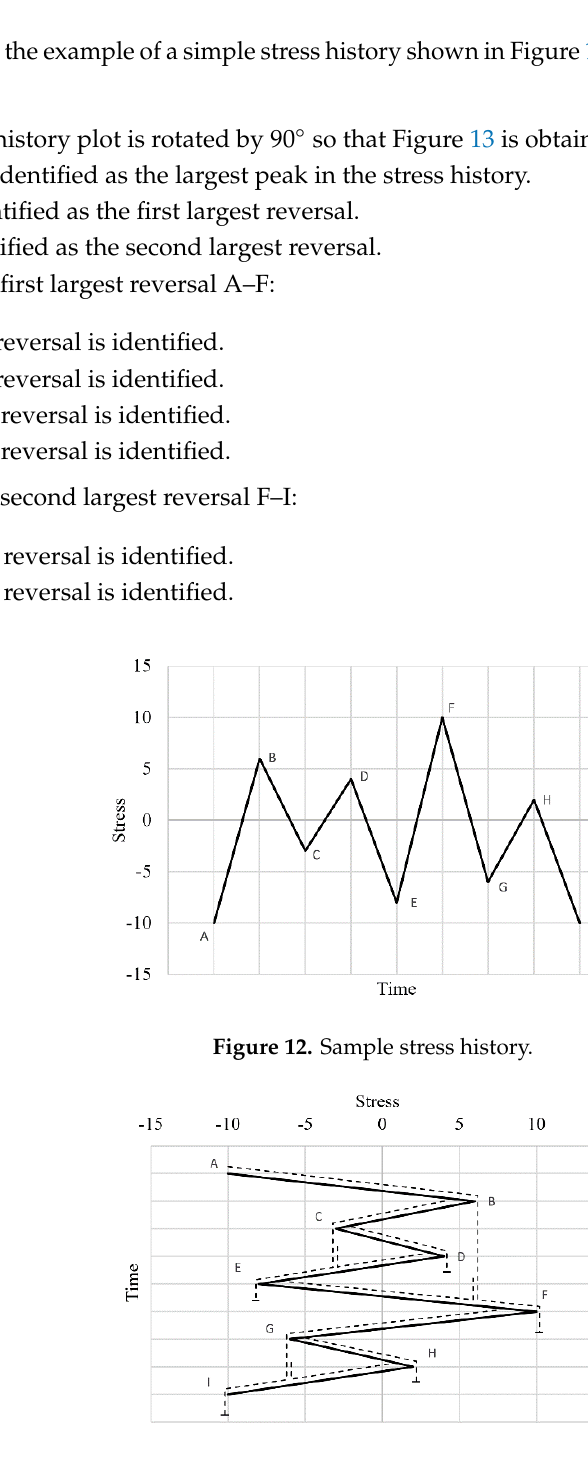
Figure 13. Stress history (rotated by 90°).